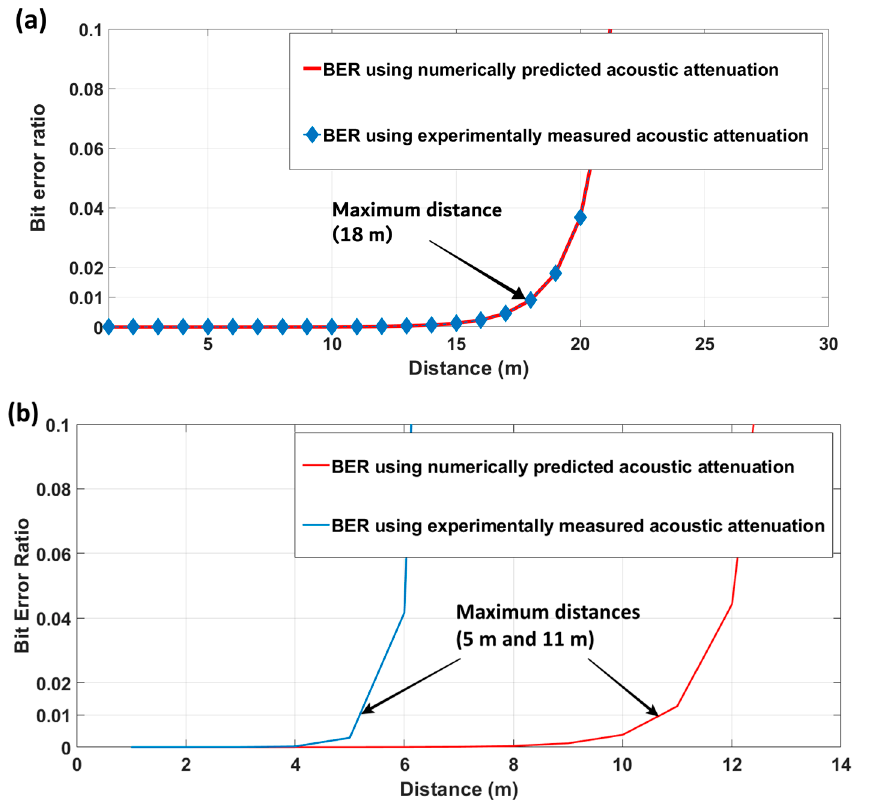
Figure 12. Acoustic data communication reliability along ( a ) exposed and ( b ) buried MDPE pipes.